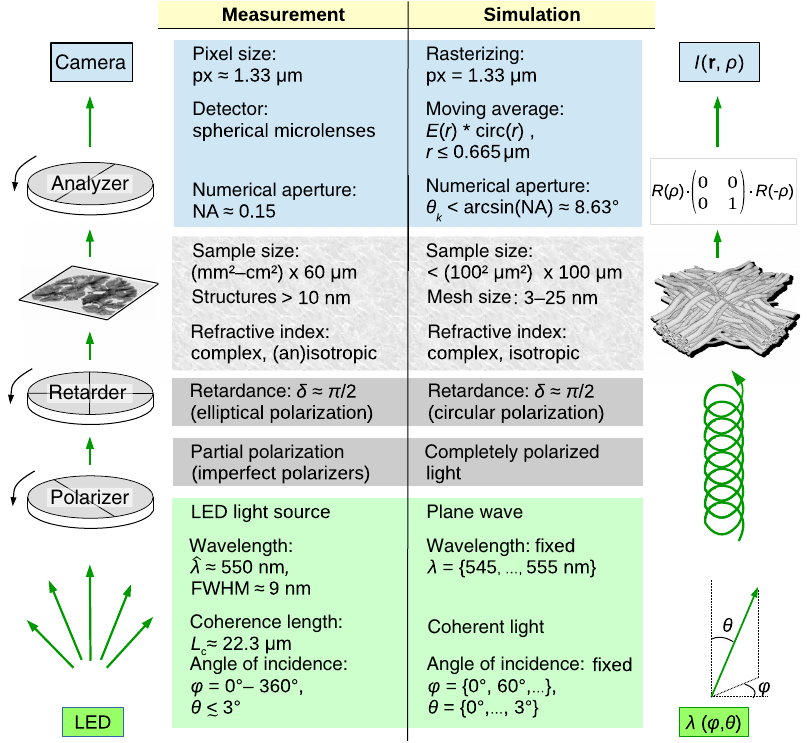
FIG. 16. Modeling of the 3D-PLI measurement. The figure and table on the left-hand side show the optical components of the polarimeter (the order of the polarizing filters is different than in the measurement, but the setup is mathematically equivalent): light source (green), polarizer and retarder (dark gray), sample (light gray), and objective lens, detector, and camera (blue). The table and figure on the right-hand side show how the optical elements are modeled by FDTD simulations: The incoherent and diffusive light ˆ λ source (LED) with peak wavelength and full width at half maximum (FWHM) is modeled by performing several simulation runs with plane waves that have different wavelengths ( λ ) and angles of incidence ( φ , θ ). The modeled light source emits coherent light that is circularly polarized. The tissue sample is represented by an artificial fiber architecture, the rotating analyzer by a rotated Jones matrix [with rotation matrix R ð ρ Þ ]. The numerical aperture (NA) of the imaging system is modeled by considering only wave vector angles θ < arcsin ð NA Þ . The spherical microlenses of the camera detector are modeled by performing a moving average over the area of the k microlens with radius r ¼ 1 . 33 μ m = 2